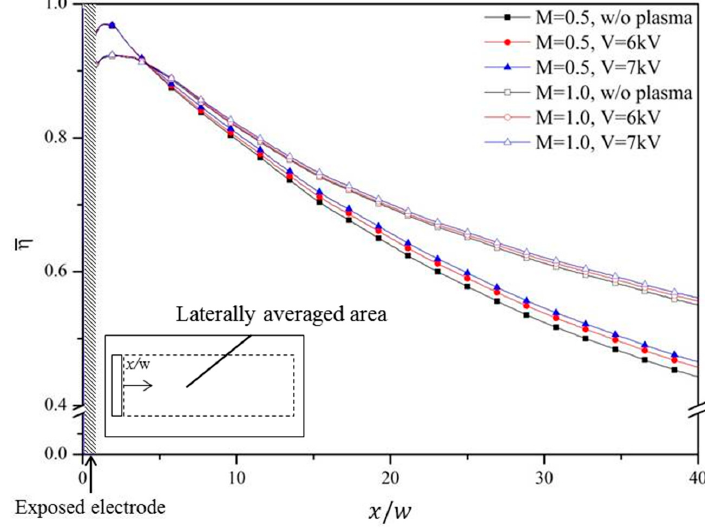
Figure 6. Laterally-averaged film cooling effectiveness ( L e = 0 w).